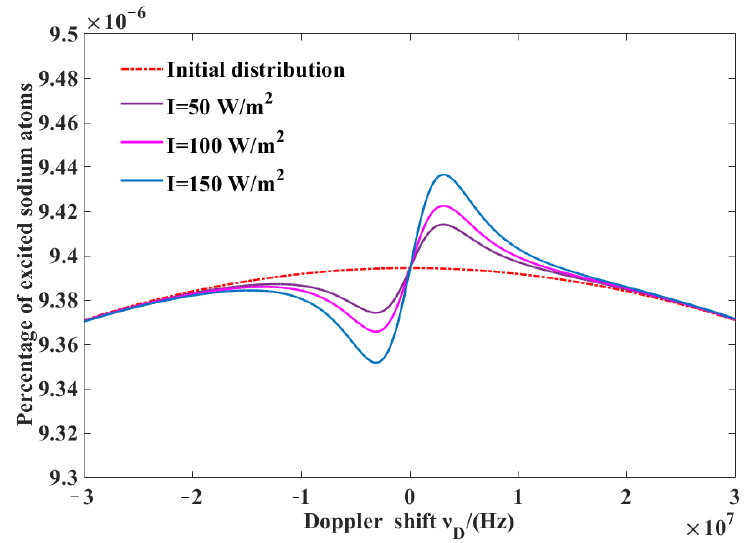
Figure 5. Normalized distributions of sodium atoms with linewidth broadening for I = 50 W/m 2 , 100 W/m 2 , and 150 W/m 2 for 0 MHz linewidth.